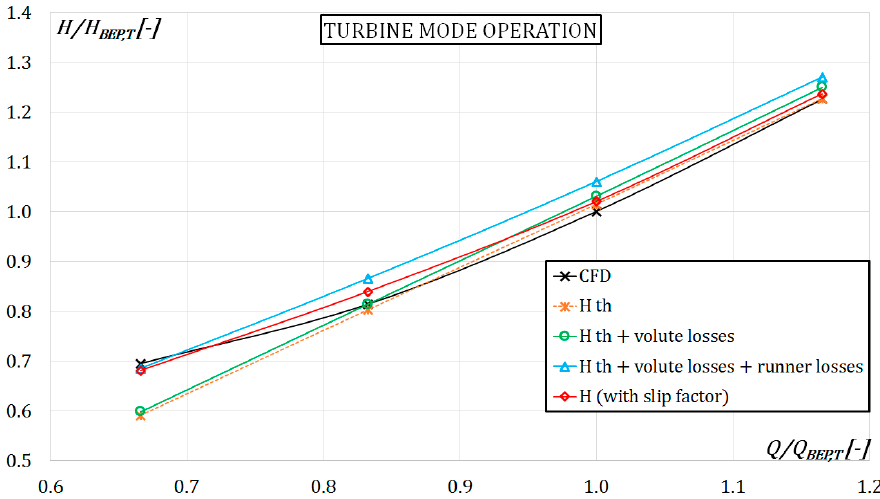
Figure 8. Comparison of different sources of losses for the performance